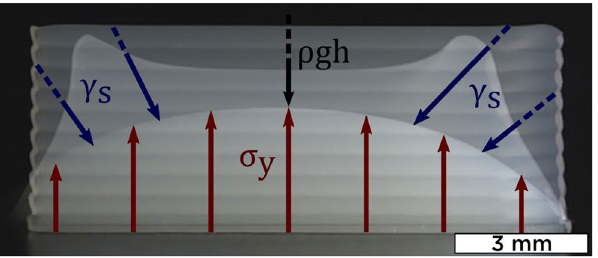
Figure 7. Frame superposition of 45 wt% boehmite gel printed after 1 h, 5 h, and 10 h of aging, with a 500 μ m